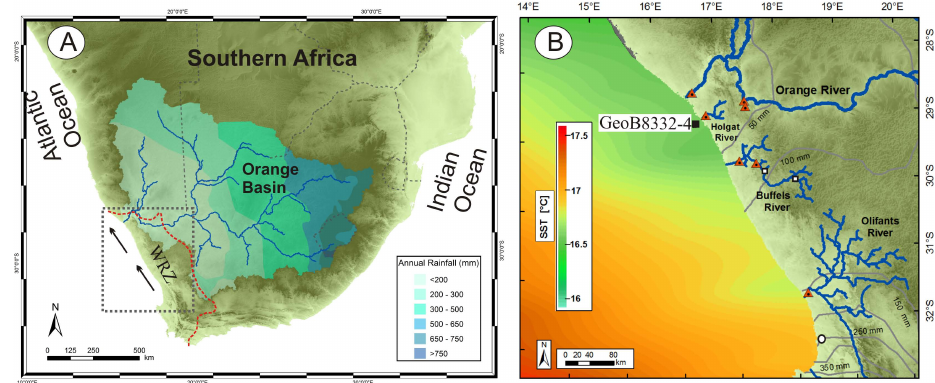
Fig. 1. (A) Map of southern Africa indicating the basin of the Orange River, annual rainfall over the basin (rainfall contour redrawn from Compton et al. (2010)), and the winter rainfall zone (WRZ) delineated by the orange line. Black arrows indicate southeasterly trade winds. Dotted square indicates area whose details is shown Fig. 1b. (B) Coastal area of southwestern Africa showing local rivers, annual precipitation (gray contours), annual sea surface temperature (Locarnini et al., 2010), location of GeoB8332-4 (black square), and riverine sediment samples used for Sr and Nd isotope analyses (orange triangles). Shown is also the approximate location of Lake Verlorenvlei (white circle) (Stager et al., 2012) and paleo-flood investigation on the Buffels River banks (white squares) (Benito et al., 2011).